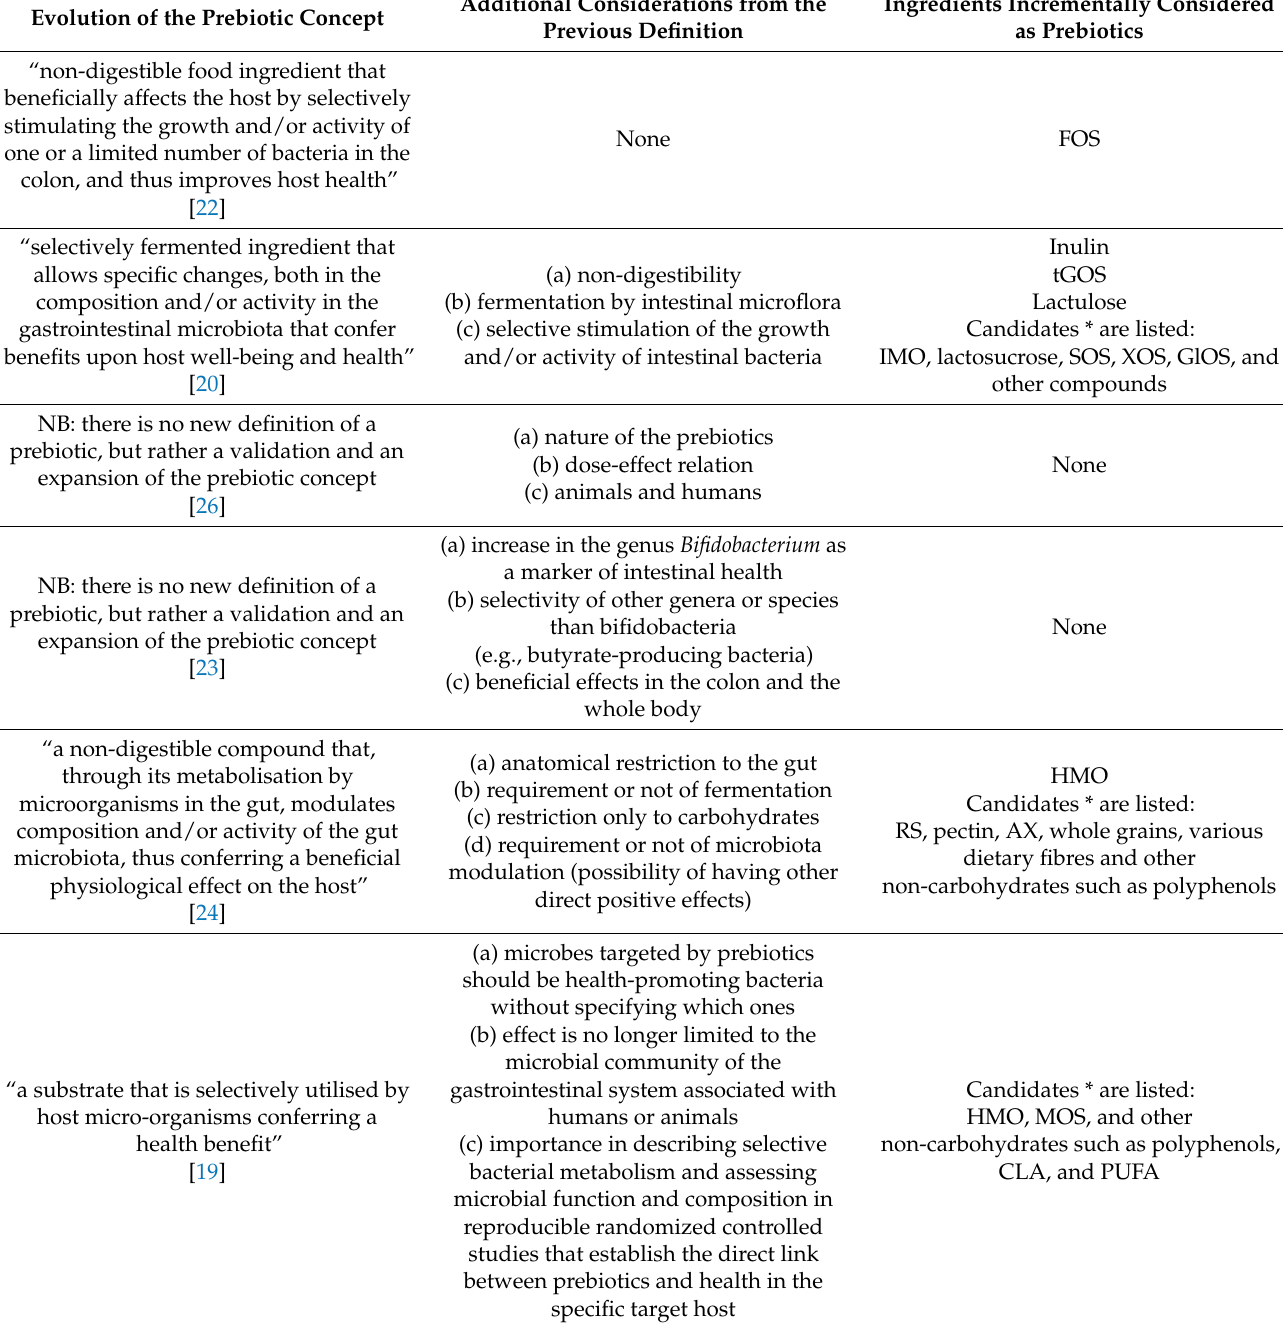
Table 1. The prebiotic concept over the years. Consisting of a panel of academic and industrial experts, the ISAPP regularly convenes to state the definition and scope of prebiotics. New considerations are gradually included along with scientific research progress, consumer interest, and technological innovations from industrial